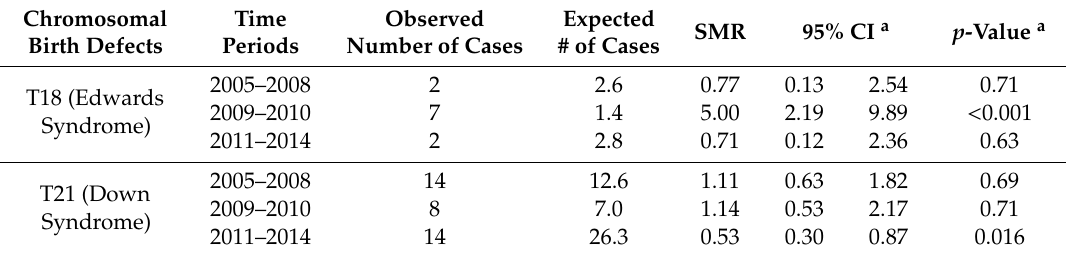
Table 2. Standardized Morbidity Ratios (SMRs) of trisomy 18 and 21 in Brazos County compared with the state-wide risk of